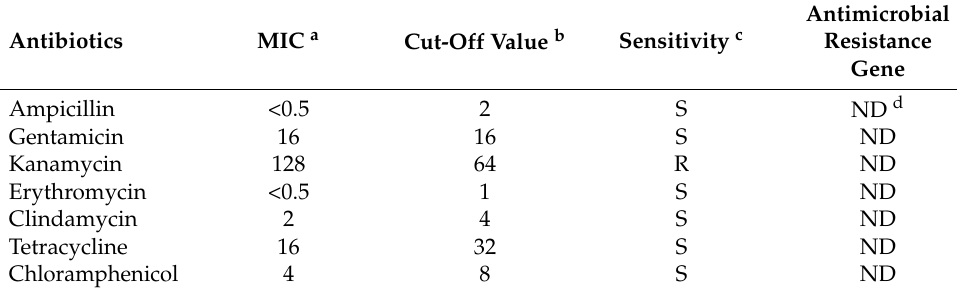
Table 2. The antimicrobial sensitivity of